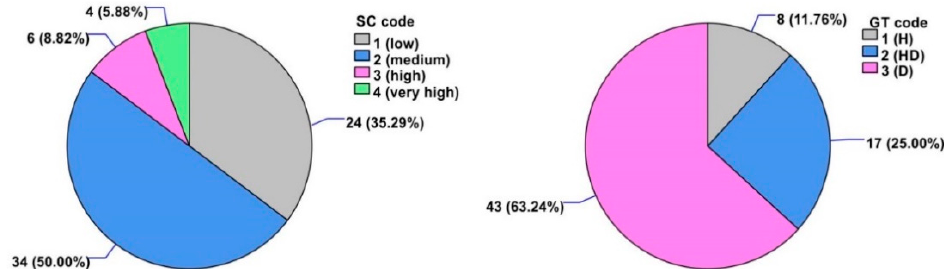
Figure 6. Pie charts for sediment coverage (SC) and genetic type of nodules (GT).